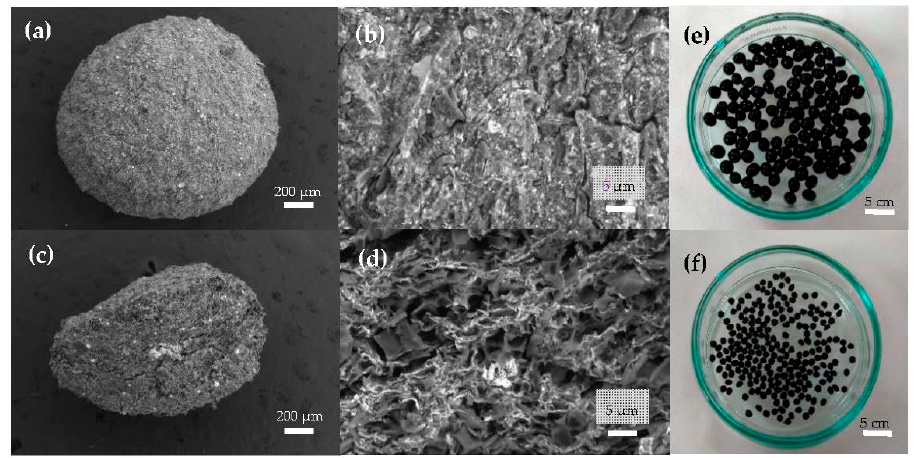
Figure 2. Scanning electron micrographs of the surface morphology of magnetic alginate activated carbon (MAAC) beads: ( a ) external surface, ( b ) surface interconnected pores at higher magnification, ( c ) cross-section, and ( d ) internal pore walls of MAAC. Digital images of ( e ) wet and ( f ) dry MAAC beads.